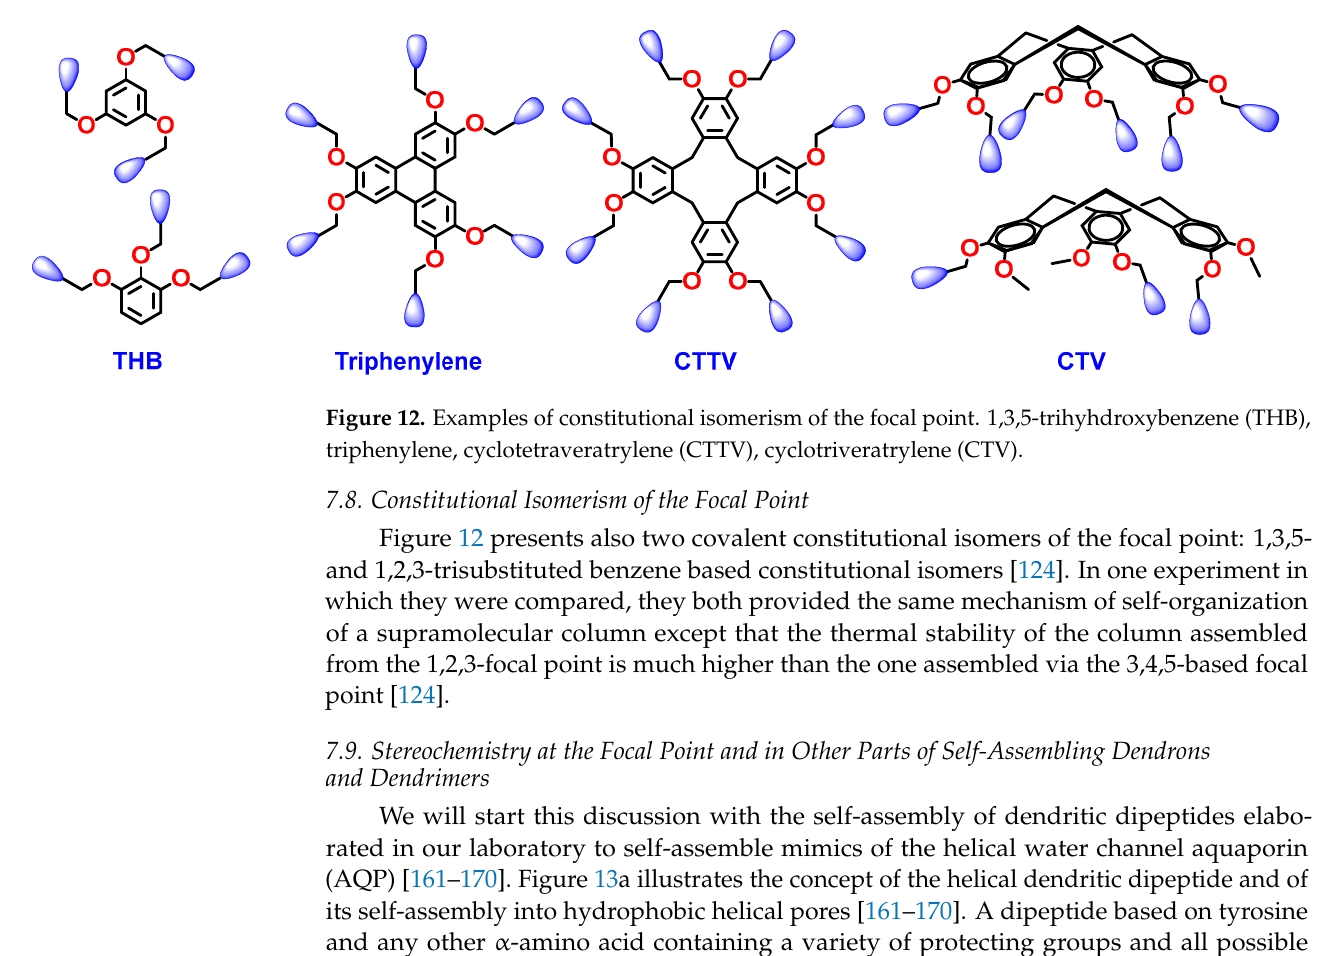
15 of 47 Figure 11. Hierarchical self-organization of the same self-assembling dendron at two di ff erent gen- erations. (4-(3,4,5) 2 12G2-X is second generation (top), and (4-(3,4,5) 3 12G3-X is third generation (bot- tom) self-assembling dendron self-assembling columnar and, respectively, spherical assemblies generating columnar hexagonal and cubic Pm 3 (cid:3364) n or A15 Frank–Kasper phases [124]. Parts of the Figure were adapted and modi fi ed from [124]. Copyright © 1998, American Chemical Society. 7.7. Covalent and Supramolecular Multiplicity of the Focal Point Multiplicity of the focal point can be covalent or supramolecular. Covalent multiplic- ity of the focal point is forced by the chemical structure employed to construct the focal point with self-assembling dendrons and is limited by the chemical capabilities available to generate multiplicity. Figure 12 illustrates several examples of architectures employed frequently in our laboratory to assemble the branching point. Multiplicities of 2, 3, and 6 that are commonly employed in our laboratory are shown in Figure 12. Supramolecular multiplicity at the focal point is spontaneously determined by self-assembly and is prac- tically unlimited as numbers. It usually matches the multiplicity number that is required to fi ll the space by self-assembly. We would like to point to a few examples of the supra- molecular multiplicity of the focal point by inspecting Figure 8 [27]. In the supramolecular columns from the right side of Figure 8, we can see a supramolecular multiplicity of 19 and 6. While a multiplicity of 6 can be also accomplished by the covalent strategies indi- cated in Figure 12, no covalent mechanism is known today to accomplish a covalent mul- tiplicity of 19. An even more striking demonstration of the supramolecular multiplicity at the focal point is observed on the left side of Figure 8. A supramolecular multiplicity of 269 is endowed by the self-assembly of the supramolecular spheres from the conical sec- ondary structure of the dendron [131]. No covalent mechanism is known to accomplish a multiplicity of 269! Numerous examples of giant supramolecular multiplicities at the focal